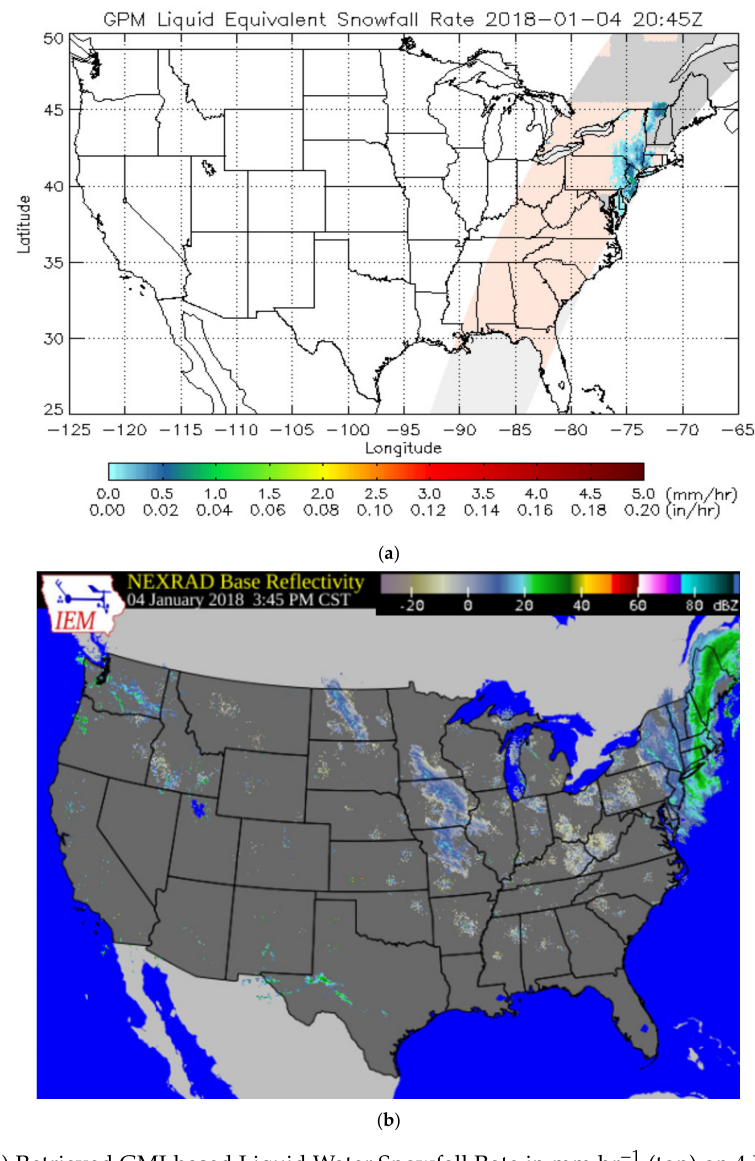
Figure 6. ( a ) Retrieved GMI-based Liquid Water Snowfall Rate in mm hr − 1 (top) on 4 January 2018 Remote Sens. 2019 , 11 , x FOR PEER REVIEW 20:45 Zulu time and ( b ) neat coincident NEXRAD base reflectivity in dbZ.